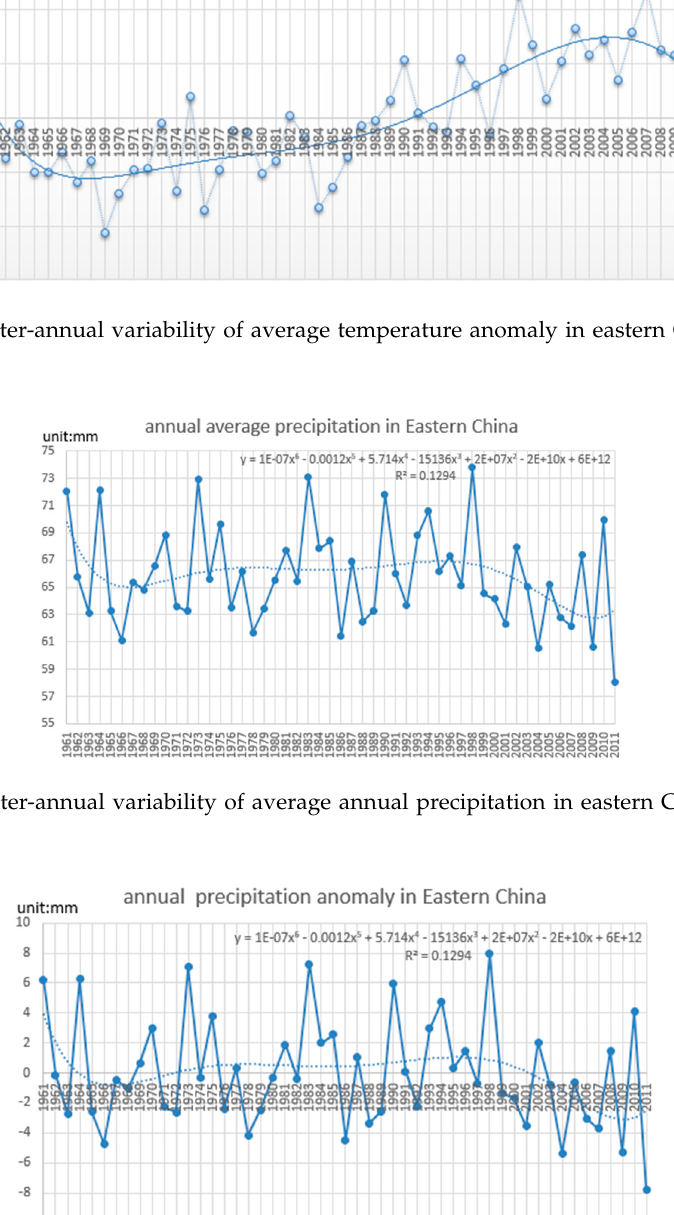
Figure 4. The inter-annual variability of average temperature anomaly in eastern China from 961 to 2011.